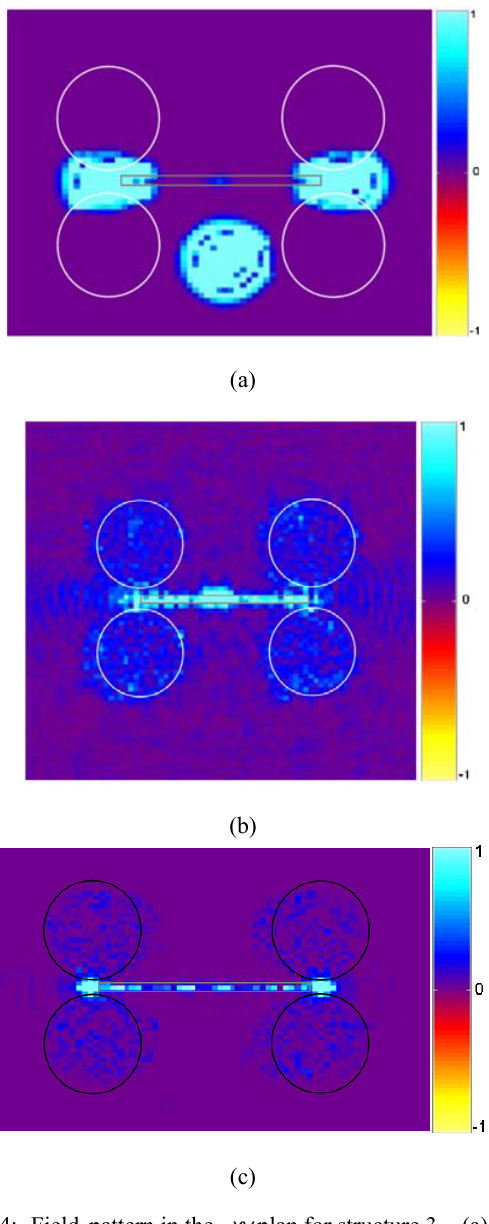
Fig. 4: Field pattern in the xy plan for structure 3 (a), ( a) Field localization at transient state between nanospheres at both ends of NW and a third source is below and close to the center of NW (b) Electric field pattern at steady state, (c) Magnetic field pattern at steady